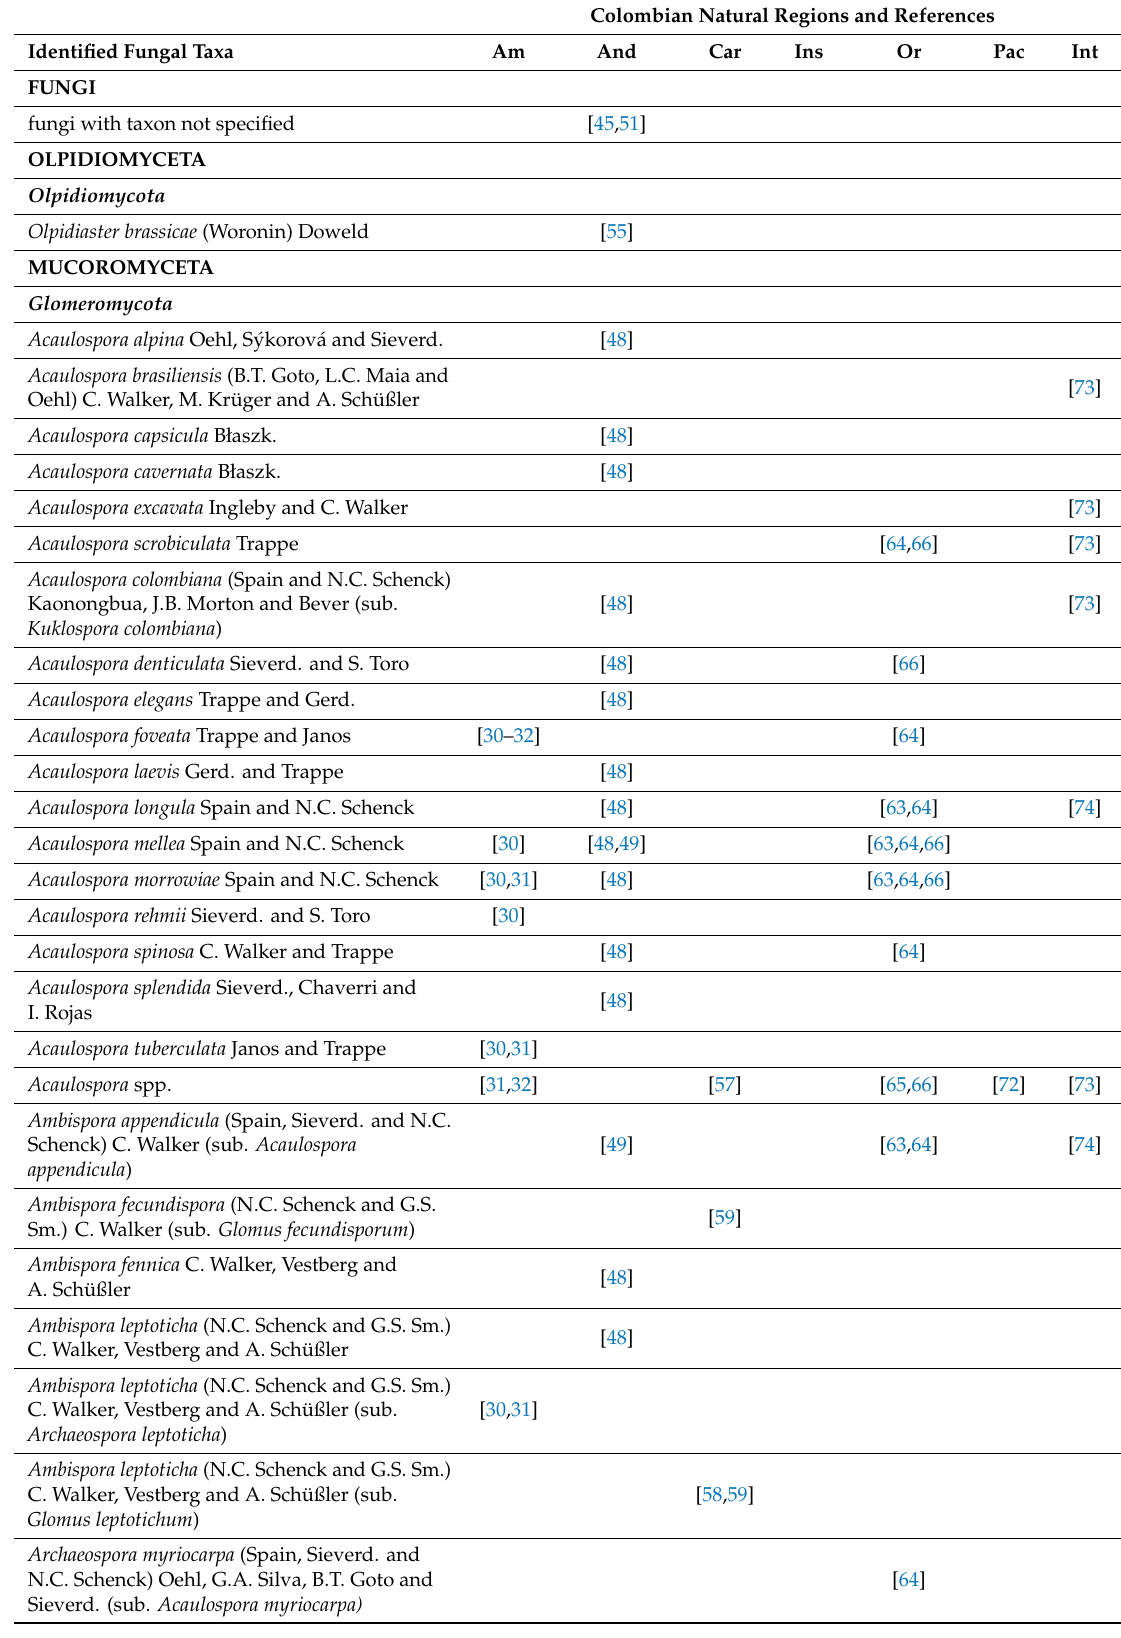
Table 1. List of taxa, studying areas in Colombia and references. Regions: Am: Amazon; And: Andean; Car: Caribbean; Ins: Insular; Or: Orinoqu í a; Pac: Pacific; Int: Interregional areas. Colombian Natural Regions and